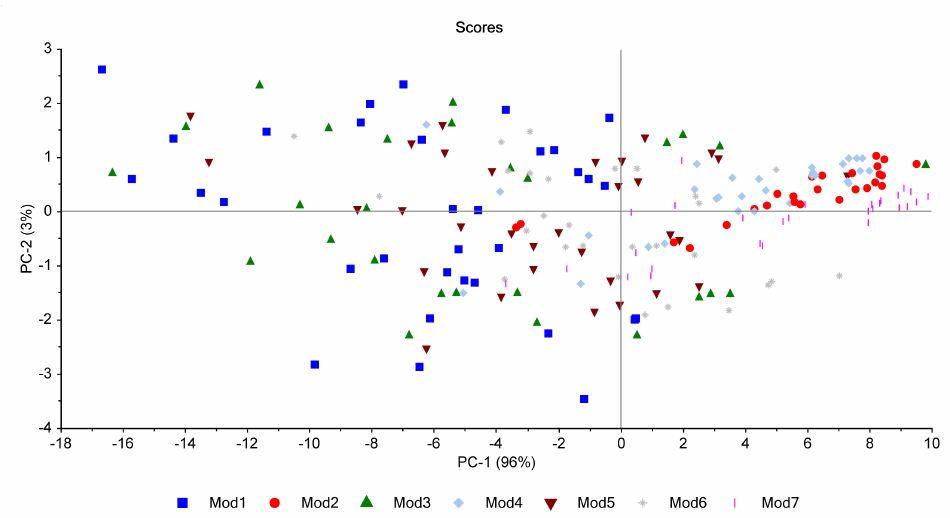
Figure 15. PCA results regrouping all models.